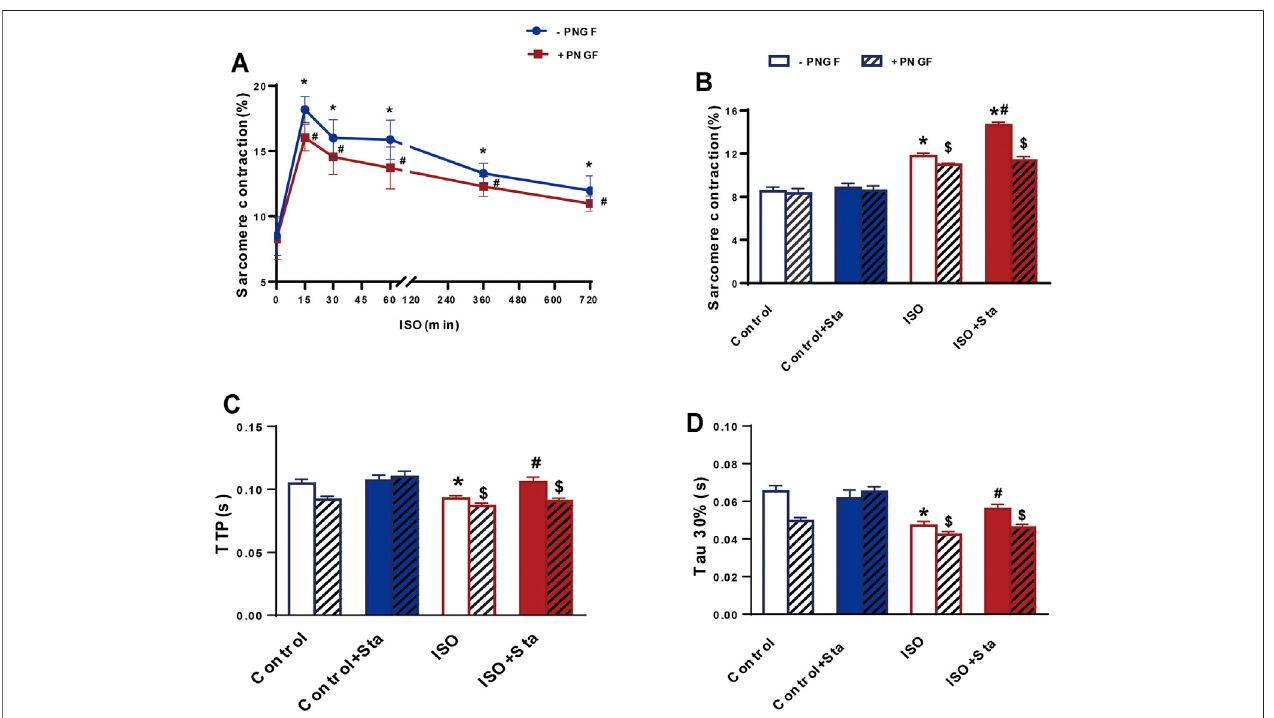
FIGURE 7 | Stachydrine hydrochloride improves myocardial contraction and diastolic function decline caused by continuous ISO stimulation by regulating N-glycosylation. (A) Quanti fi cation ofsarcomerecontraction after PNGaseFdigestion exposedtoISOatdifferenttimepointsinAMVMs( n > 30cellsfrom3miceineach group). (B – D) Quanti fi cationofStaonsarcomerecontraction,TTPandTau30%inAMVMsexposedtoISOat720 min( n > 20cellsfrom3miceineachgroup).Thedata are expressed as mean ± standard error of mean, * p < 0.05 versus control; # p < 0.05 versus ISO; $ p < 0.05 versus -PNGF. AMVMs, adult mouse ventricular myocytes; ISO, isoproterenol; Sta, stachydrine hydrochloride; Tau, relaxation time constant; TTP, time to peak.